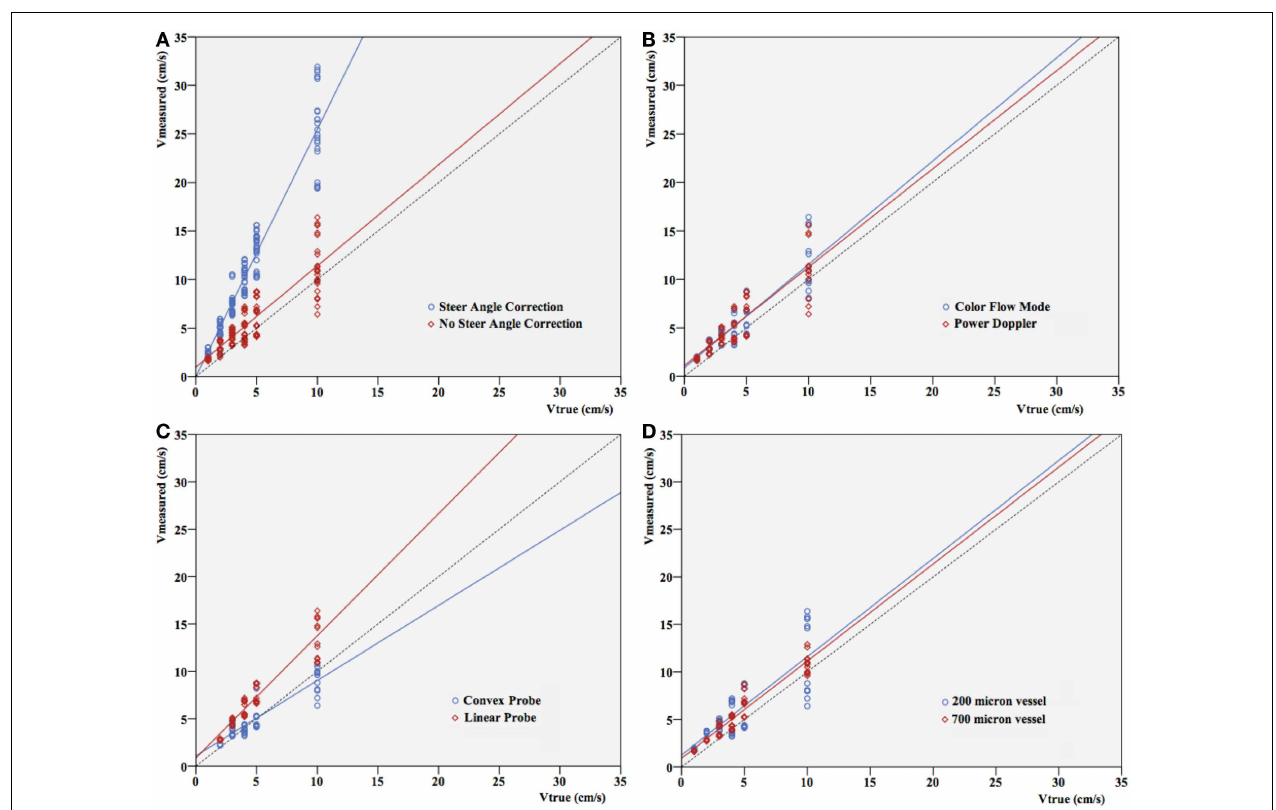
probe, (D) vessel size. Since applying steer angle correction leads to significant ( p < 0.001) overestimation of velocity, velocities in (B–D) are without applying steer angle correction.The dotted line represents the line of equality.